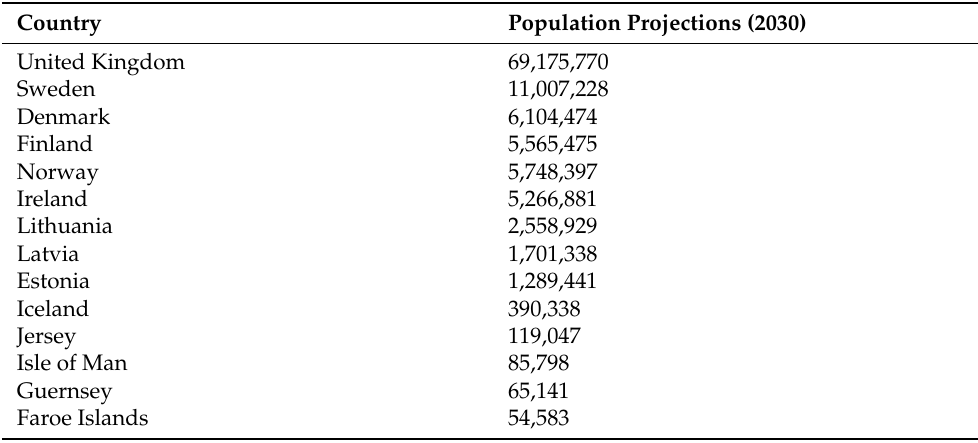
Table 4. Population estimates and projections (2030) in Northern Europe